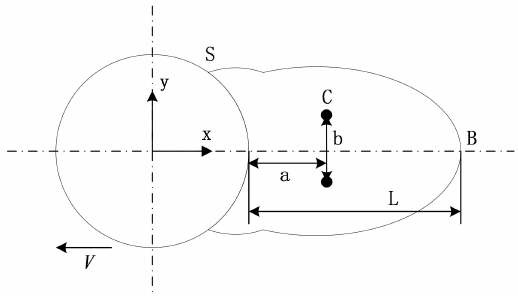
Figure 3. Schematic diagram describing the parameters of the wake.